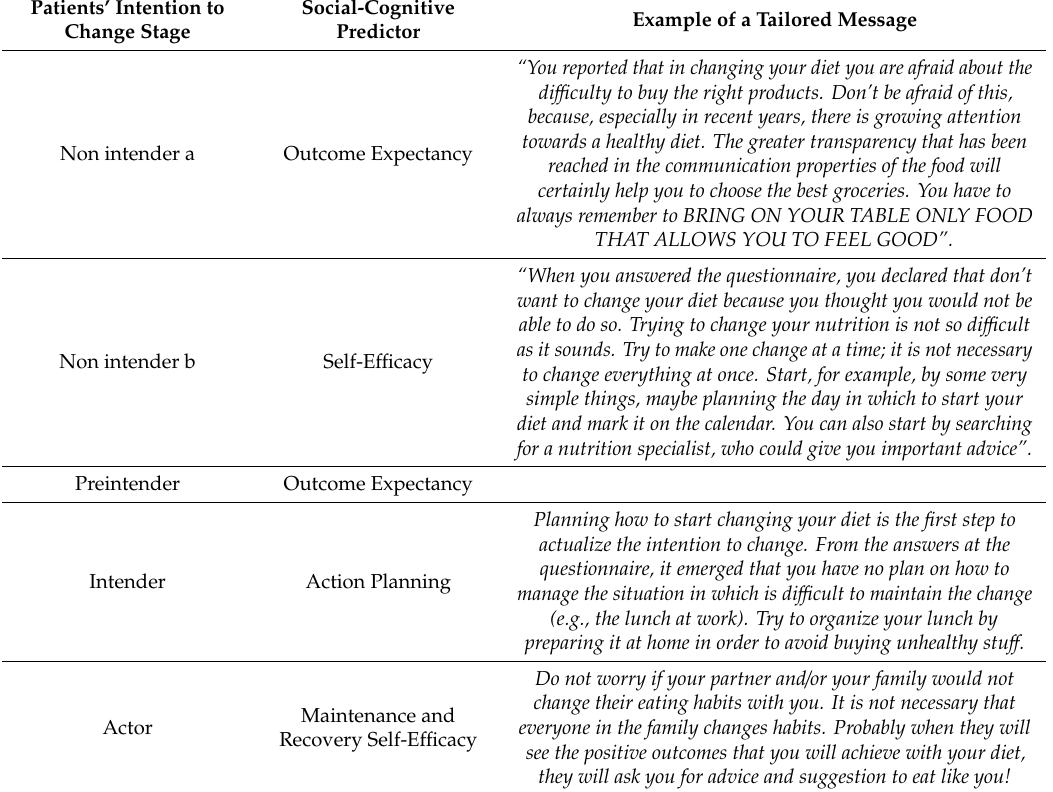
Table 2. Tailoring scheme for the development of messages related to the